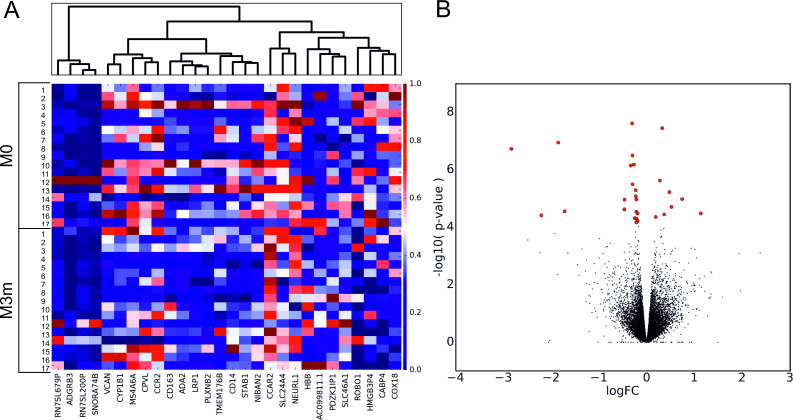
Metformin-induced alterations of gene expression profiles.(A)—Heat map and hierarchical clustering of 28 DEGs identified. Each row corresponds to one subject in the respective time-point and each column represents a DEG. Normalized sequence read counts were rescaled to lie in the range [0,1] and further used to estimate the difference between the gene expression levels in two time-points. DEGs with analogous expression values were clustered at the column level. (B)—Volcano plot showing the distribution of gene expression in the analyzed contrast. Significance versus log2 fold change is plotted on the y and x axes, respectively, calculated using likelihood ratio test and edgeR. Red dots represent the significant DEGs (FDR < 0.05), black dots–non-significant genes. M0 –time point of blood collection before administration of metformin; M3m –time point of blood collection after metformin therapy for three months.